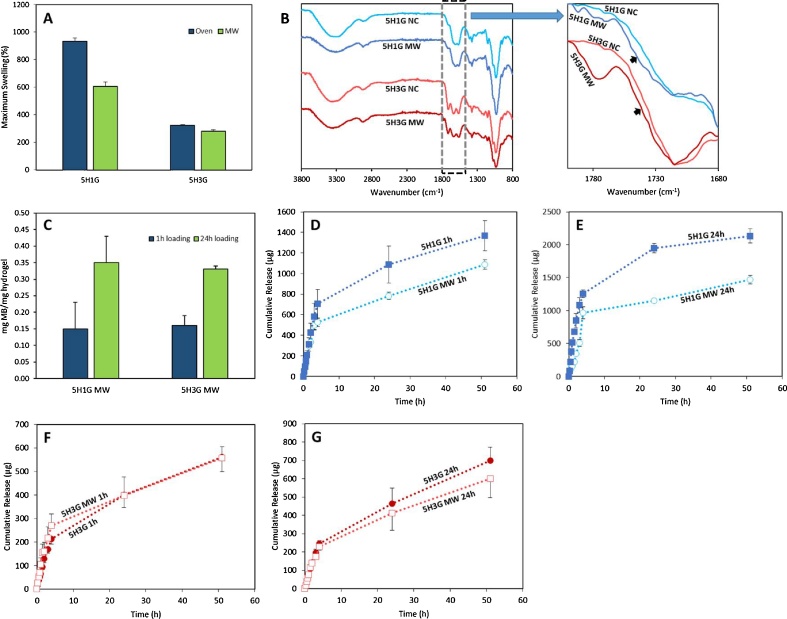
Maximum swelling in PBS of 5H1G and 5H3G hydrogels crosslinked in the oven and in the microwave (A). FTIR spectra of 5H1G and 5H3G hydrogels before and after crosslinking in MW (B). A magnified spectra of the region between 1800 and 1680 cm−1 is included (right). MB loading for 5H1G and 5H3G for two different loading times (1 h and 24 h) (C). Comparative of the cumulative MB release from 5H1G hydrogels crosslinked in the oven and in the MW prepared using two different loading times: 1 h (D) and 24 h (E). Comparative of the cumulative MB release from 5H3G hydrogels crosslinked in the oven and in the MW prepared using two different loading times: 1 h (F) and 24 h (G). (Means ± S.D; n = 3).